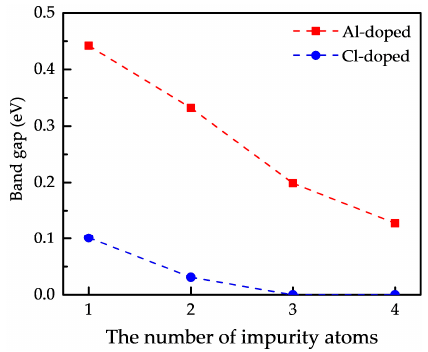
Figure 7. The curves about the band gap of doped phosphorene in terms of the number of impurity atoms.